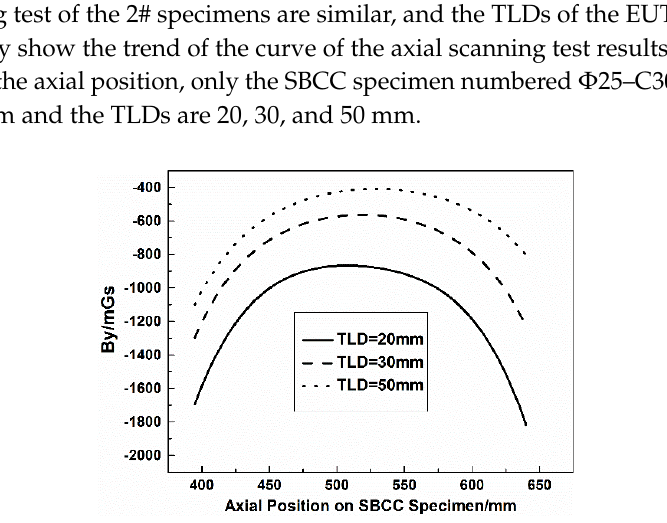
Figure 8. The axial scanning test results of SBCC specimen at lift-off heights (LH) = 1 cm.